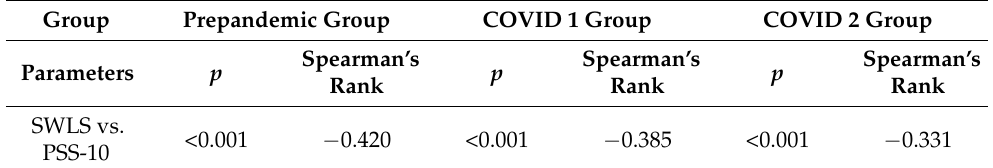
Table 5. Spearman’s Rank Correlations between the Levels of Life Satisfaction and Perceived Stress.